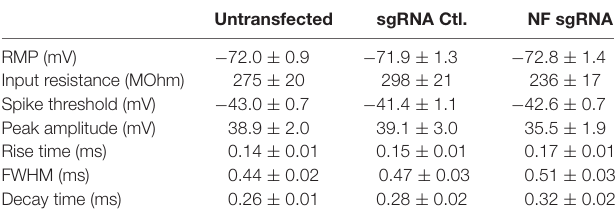
TABLE 1 | Summary of electrophysiological measurements. Untransfected sgRNA